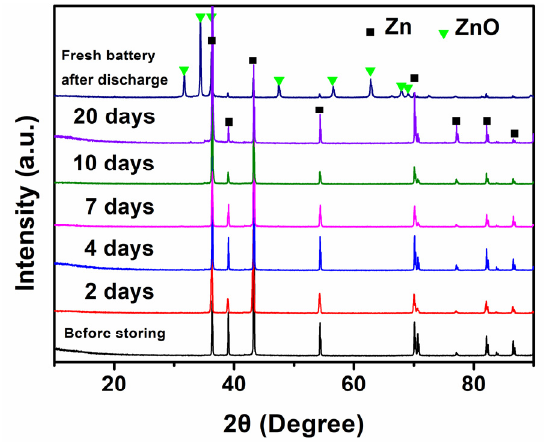
Figure 6. XRD patterns of the zinc anode stored for various days.